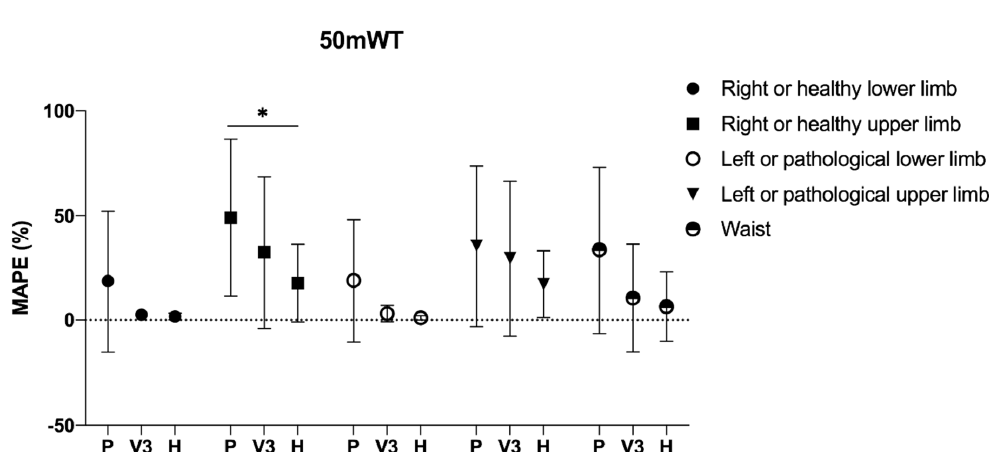
Figure 1. Bland–Altman plots for difference vs. average of the two measurements methods (step counter and manual counting) during timed up and go test (TUG) for the five different step counter positionings for the pathological group ( n = 43). Dashed lines represent +95% (upper line) and − 95% (lower line) of the limits of agreements. Legend: LoA, Limits of Agreement.